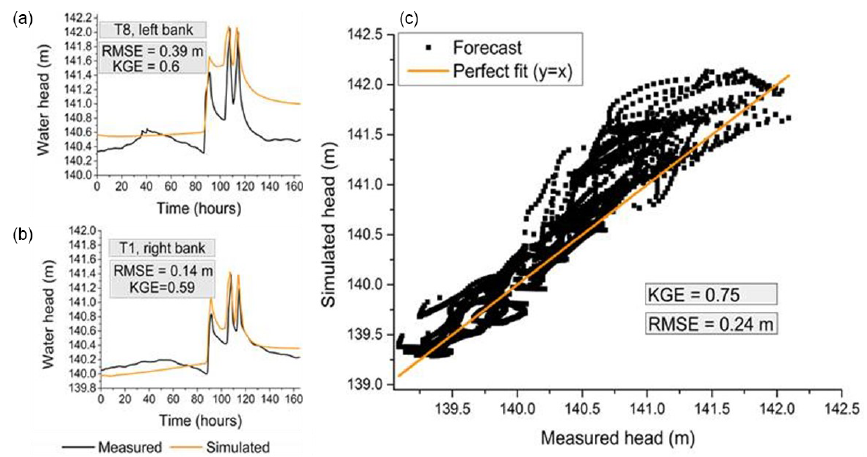
Figure 6. Comparison between simulated and measured hydraulic heads in the subsurface during the validation period. (a, b) Evolution over time at the two transects, that is, the worst (a) and best (b) transects regarding RMSE. (c) Local in space and time values of simulated hydraulic heads as a function of observed ones. RMSE is the root mean square error, and KGE is the Kling–Gupta efficiency.